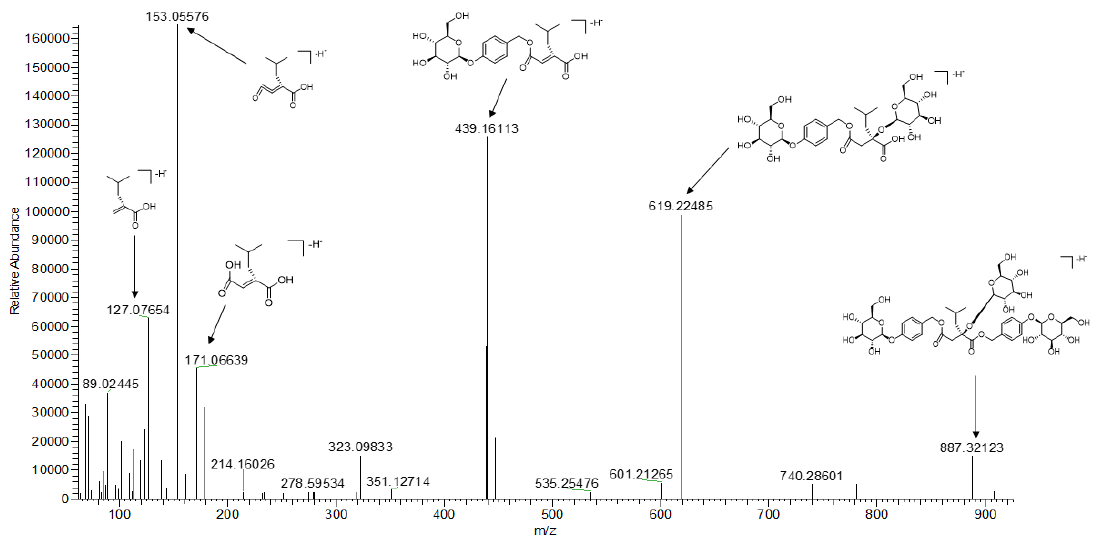
Figure 2. The possible fragmentation mechanism of dactylorhin A.